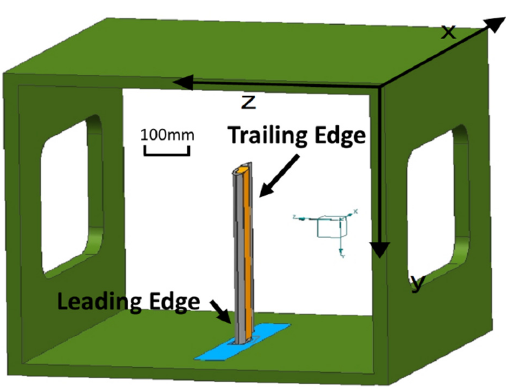
Figure 11. Model Figure 11. Model coordinates.